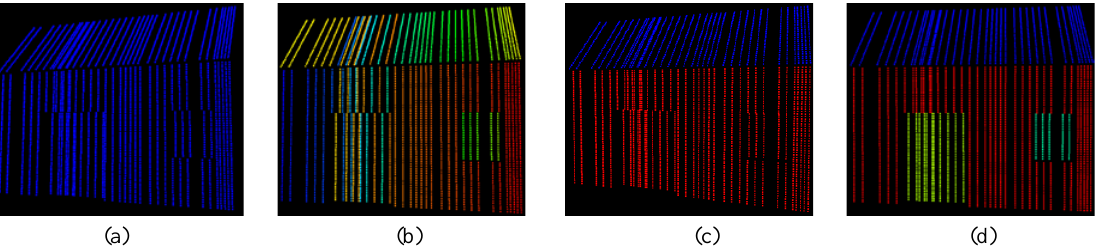
Figure 4. RGPL result for dataset 1: (a) point cloud; (b) different scan profiles ; (c) group of parallel scan profiles ; (d) final result. Different regions are indicated by different colours